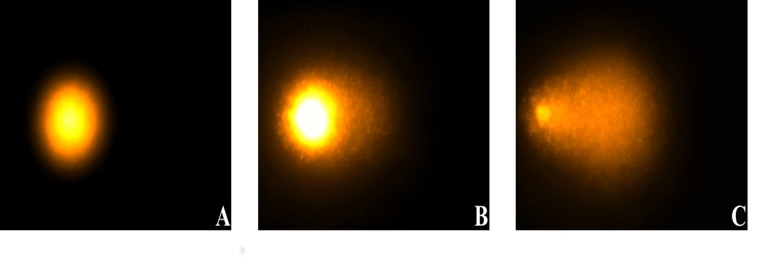
Comet assay images after DNA-staining with ethidium bromide.
A Undamaged OSC-19 cell with intact DNA and no migration. DNA fragmentation leads to a faster and further migration into the electric field, which results in a figure shaped like a comet with undamaged DNA in the head and damaged DNA in the tail (B+C). The brighter and longer the tail, the higher the level of DNA fragmentation. B OSC-19 cell with a moderate CAP induced DNA-damage. C Representative image of high DNA-fragmentation.